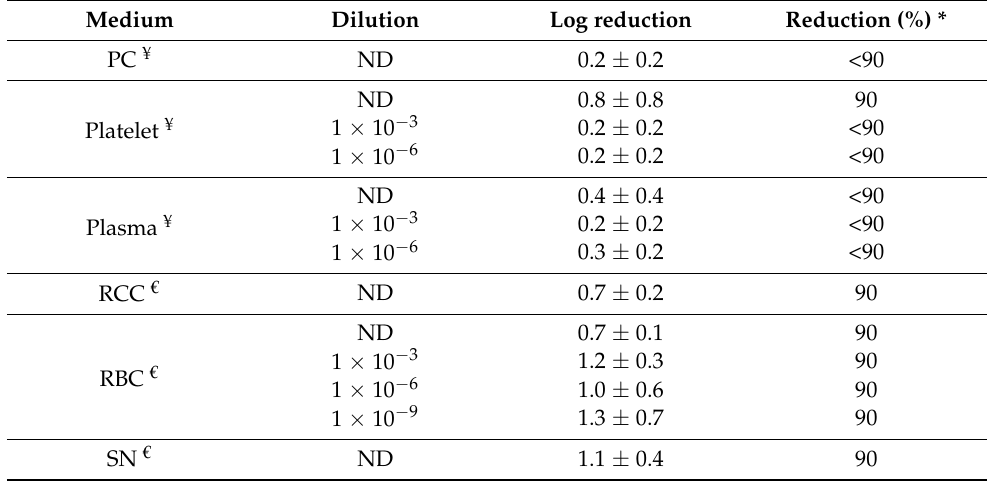
Table 3. S. aureus reductions of MAAC-treated plasticized PVC in blood